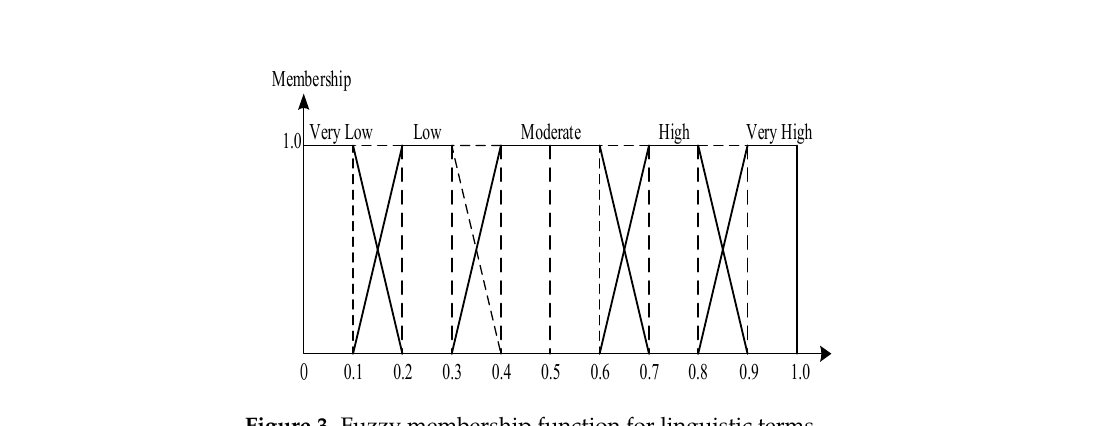
Figure 3. Fuzzy membership function for linguistic terms. Table 2. Fuzzy ratings for linguistic terms of risk factors.